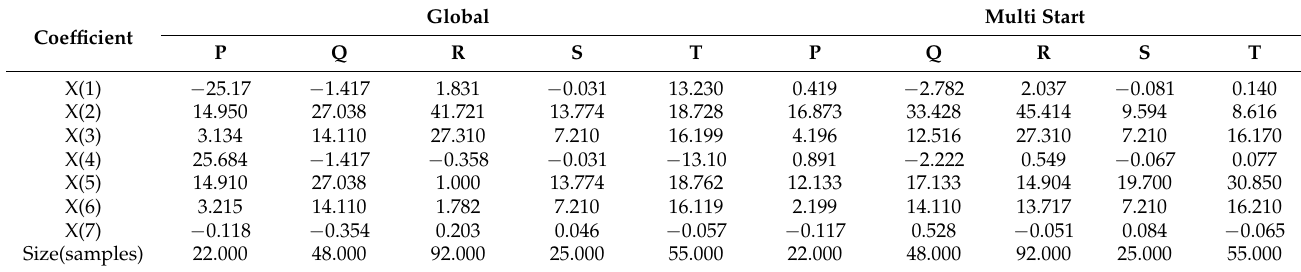
Table A3. Coefficient to fit the model with paced beat (PB).